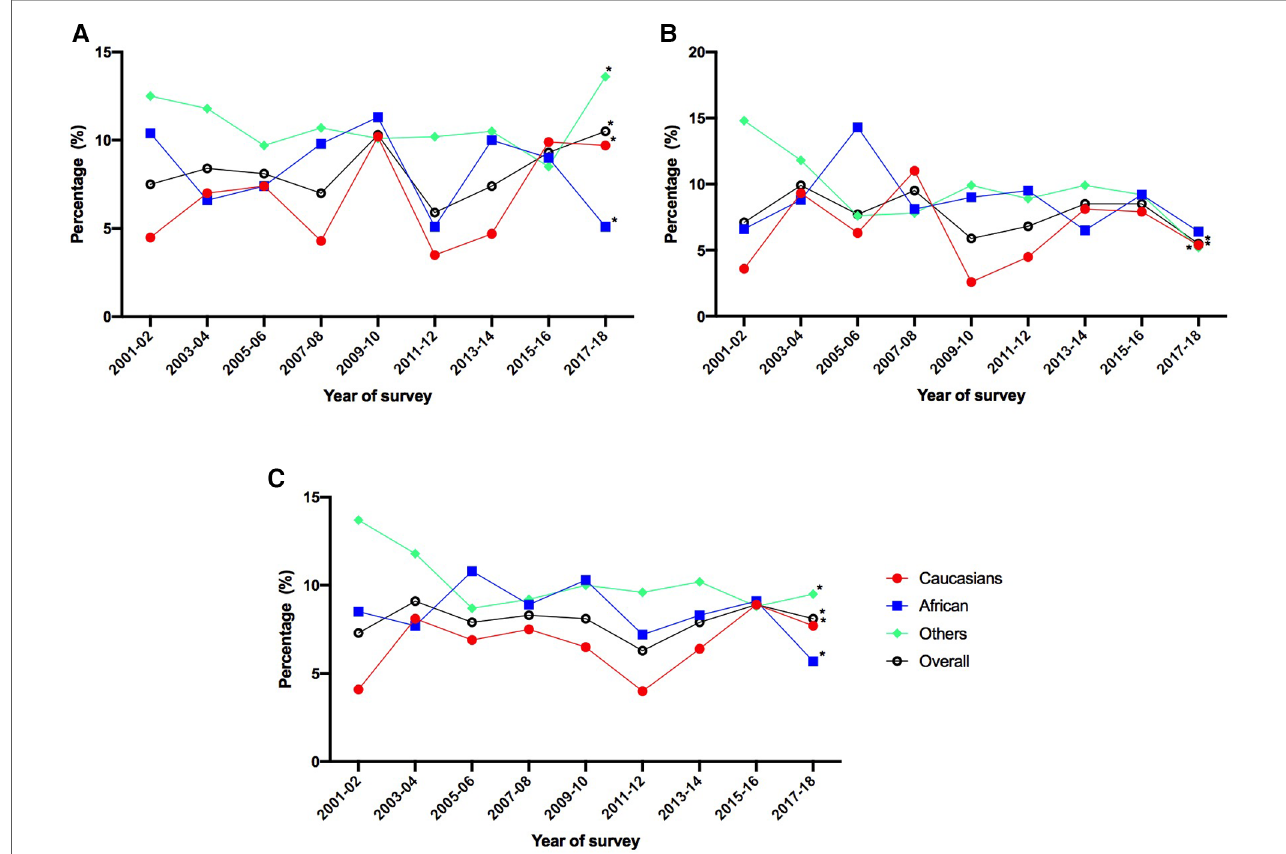
FIGURE 1 Overweight/obesity prevalence in children by ethnic group and survey year for each sex. Caucasian: Caucasian, African: African American, Others: other ethnicities, Overall: All participants gathered. A: Male, B: Female, C: Overall . *p-value <0.05 from column proportion test between 2001 – 02 and 2017 –